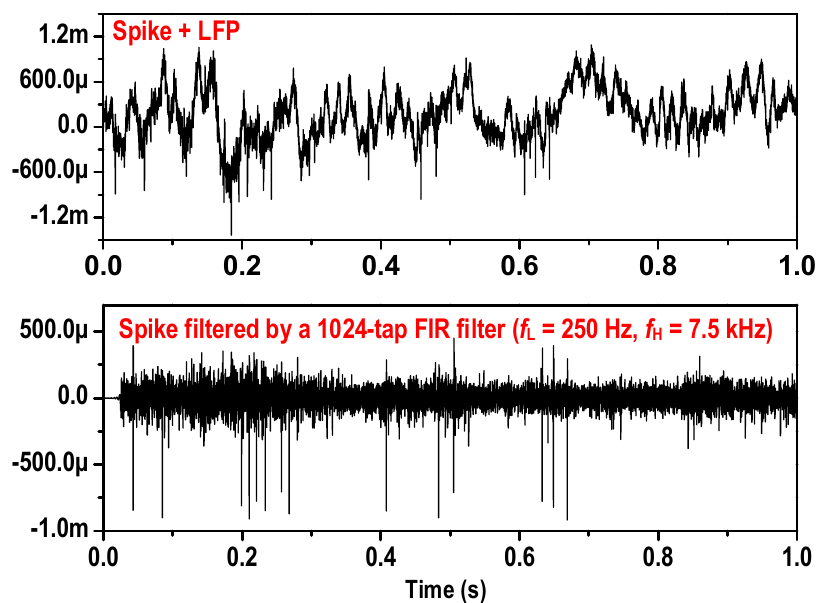
Figure 16. In vitro characterization: (top) Input referred neural data including local field potential (LFP) and spike; (bottom) Software filtered neural signal showing only spikes.